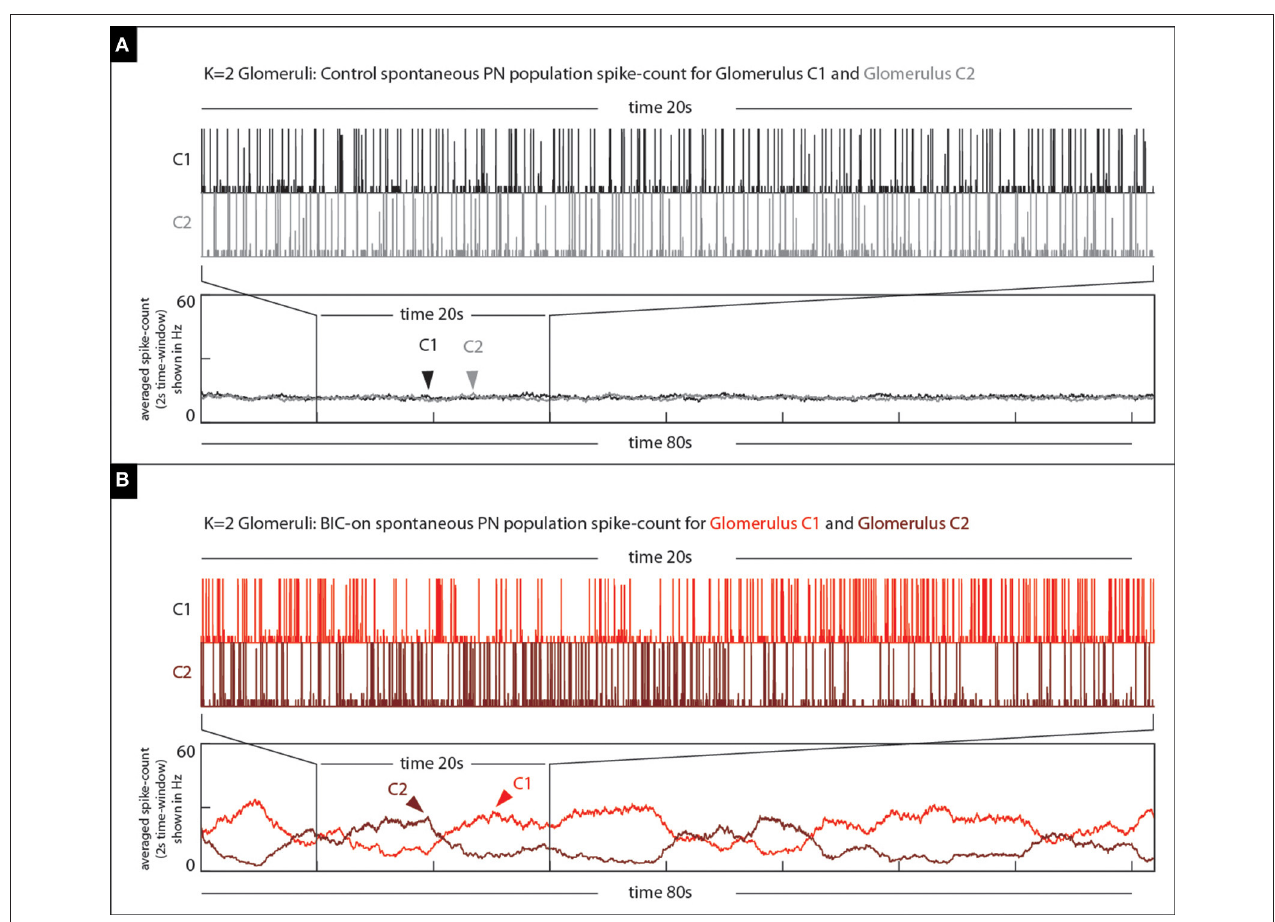
FIGURE 13 | Our model qualitatively reproduces the BIC-induced phenomena illustrated in Figure 12. (A) On top we show the spontaneous PN-activity for both glomeruli (two shades of gray) in a K = 2 glomeruli model. The time-averaged spike-count (2s bins) is shown on the bottom. (B) On top we show the spontaneous PN-activity for both glomeruli (two shades of red) in the same K = 2 glomeruli model under the BIC-on state. Note that not only are there long periods of elevated activity observed within each of the glomeruli, but also that these periods of activity are anti-correlated with one